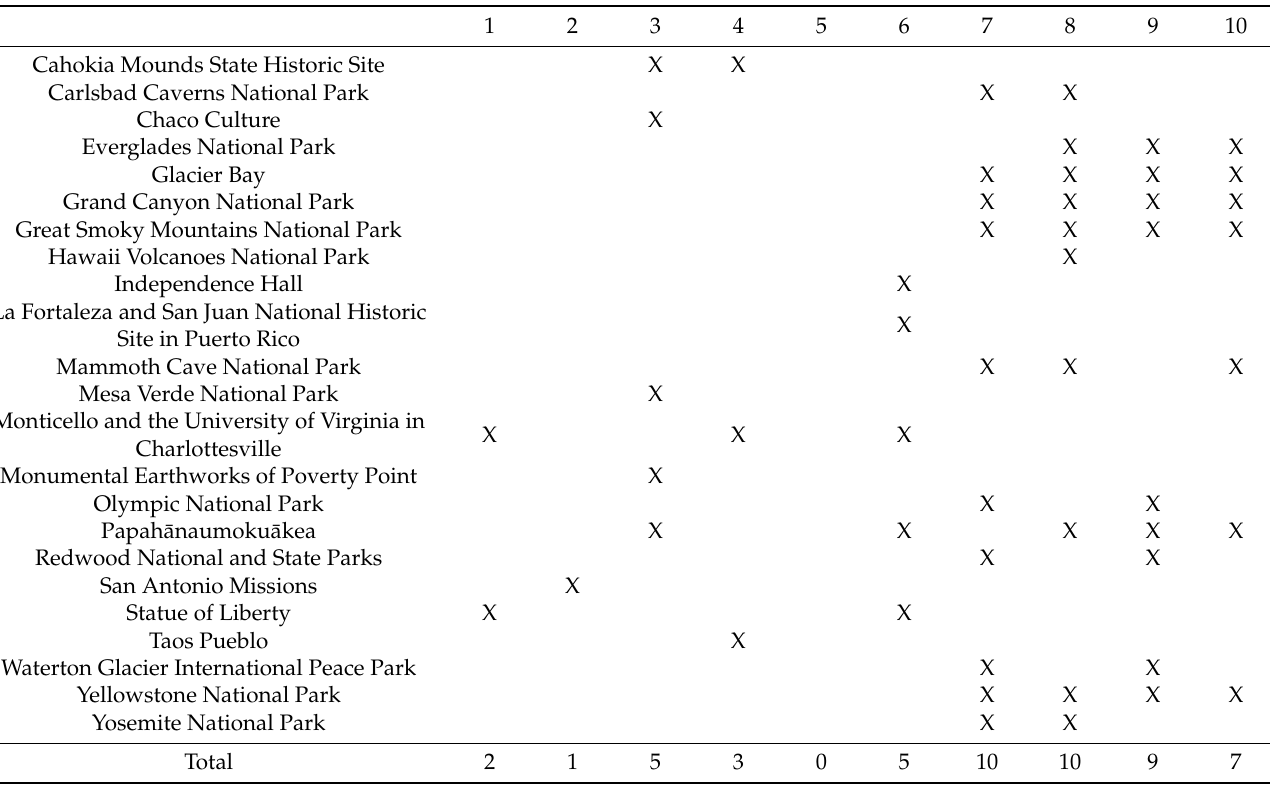
Table 4. World Heritage Areas, United States and their listing criteria (Criterion 7